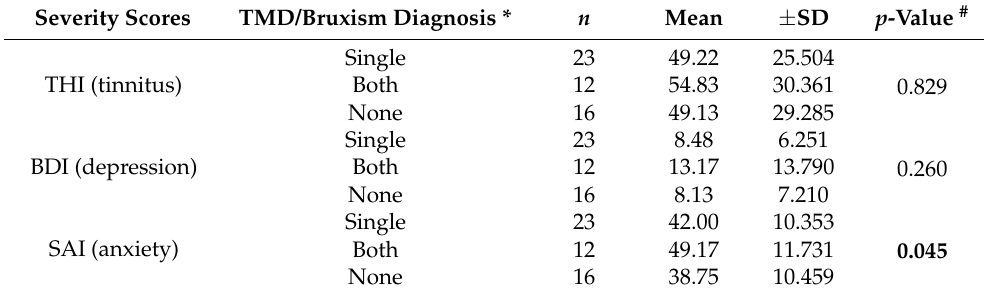
TMD or bruxism, and tinnitus combined TMD and bruxism